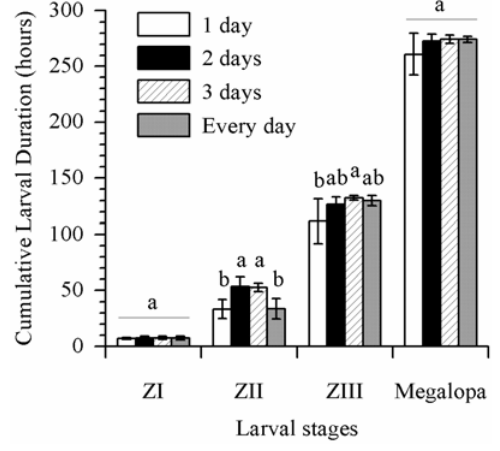
Fig. 10–Cumulativelarvaldurationinhours(CLD,average ± standard deviation) of Lepidophthalmus siriboia larvae reared in the laboratory and submitted to an initial starvation period. 1 day (treatment 1), 2 days(treatment2), 3days(treatment3), nofeeding(controltreatment). Significant differences are represented by letters when P < 0 . 05 after Dunn’s test. Treatments with at least one same letter in common did not differ statistically (α = 0 , 05 ) . ZI, ZII, ZIII (zoeal